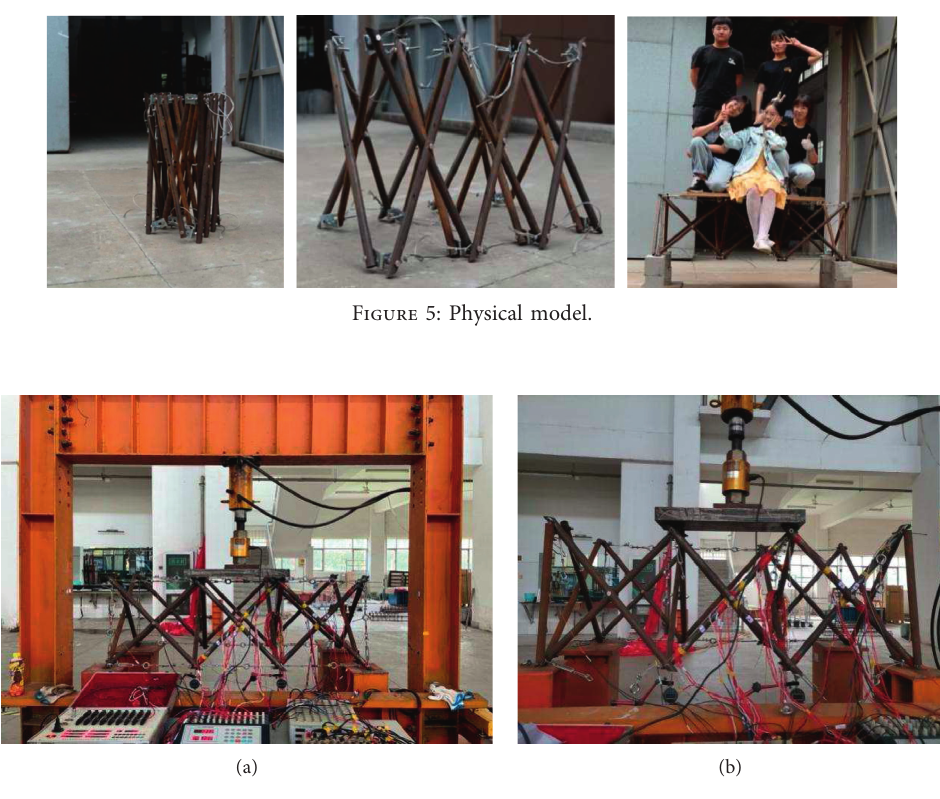
Figure 6: Test models: (a) cable-strengthened structure and (b) cable-free structure.